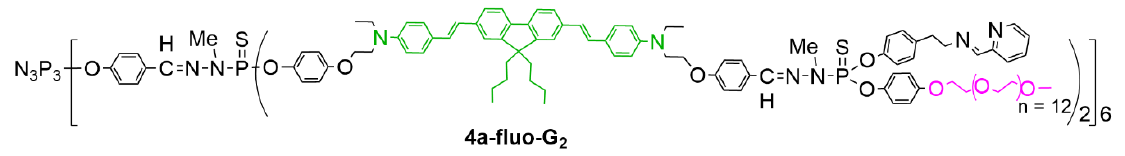
Table 1. IC 50 values (nM) and safety ratios (IC 50 EPC/IC 50 KB and IC 50 EPC/IC 50 HL-60).